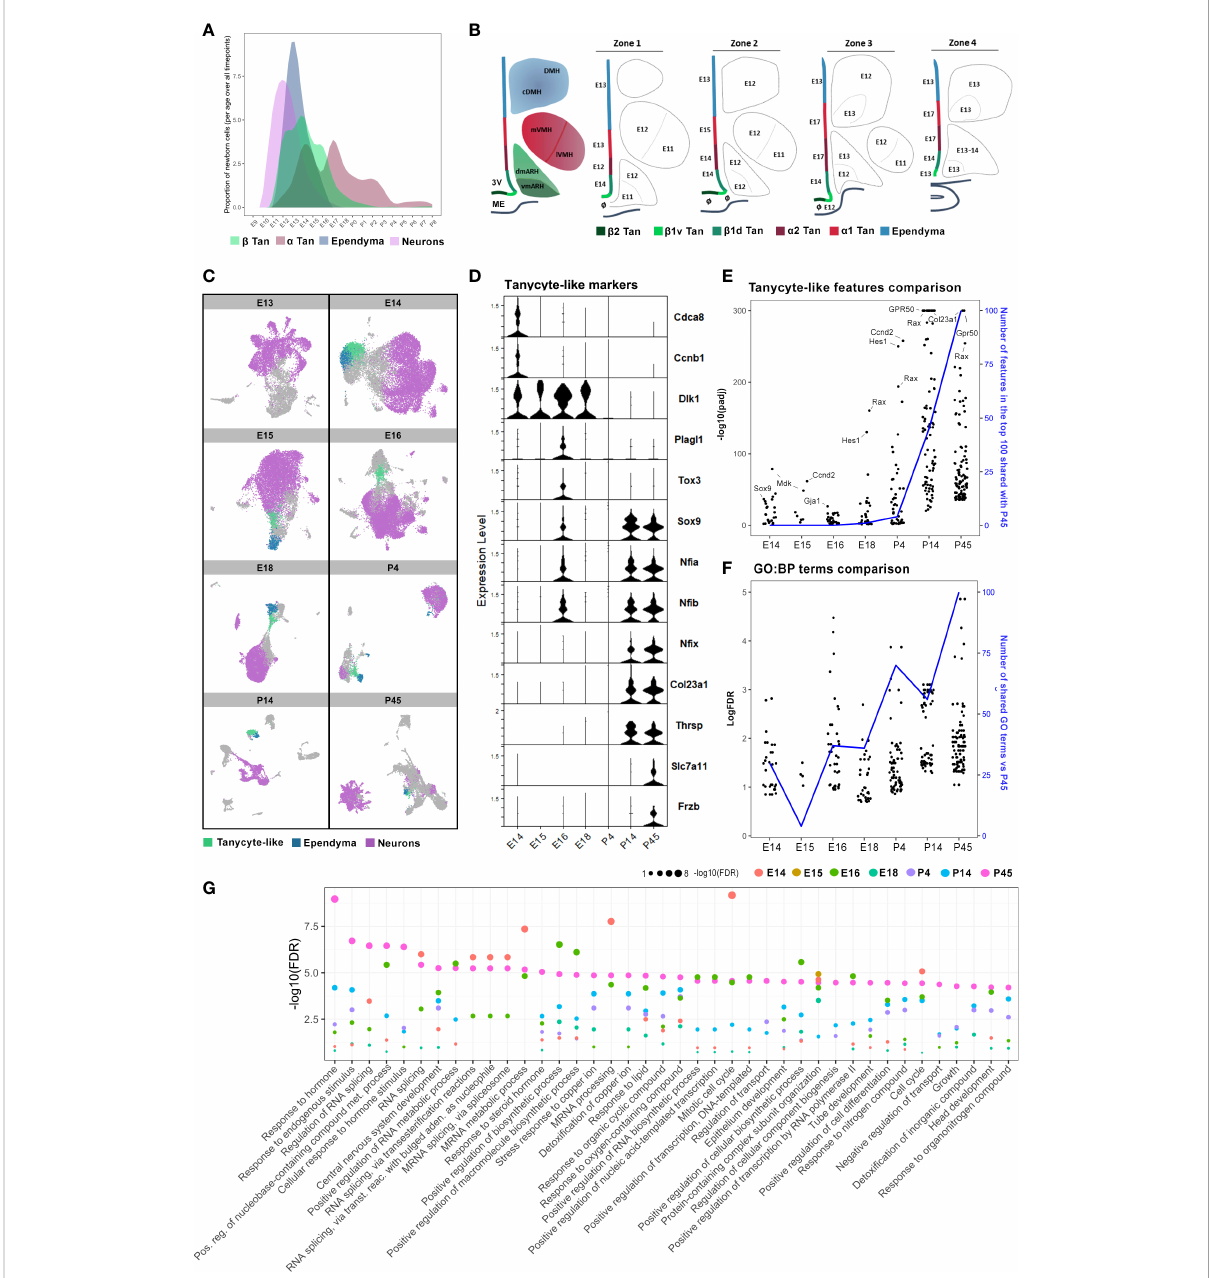
FIGURE 7 Cellular and molecular hypothalamic generation of mature tanycytes. (A) Representative plot illustrating the patterns of neuron, ependymal, and tanycyte generation across embryonic and early postnatal development extrapolated from our quanti fi cations. (B) Rostrocaudal neuroanatomical representations of the developmental peaks of BrdU integration along the ventricular wall and hypothalamic nuclei. The ages indicate the peaks of genesis. The symbol ø indicates no clear peak of genesis ( i.e ., either multiple peaks or a continuous generation). (C) UMAP plots showing neuron (pink), ependymal (blue), and tanycyte-like (green) clusters in diencephalic and hypothalamic scRNAseq datasets (26), from E13 to P45, per developmental time point. (D) Violin plot showing speci fi c features in tanycyte-like clusters across developmental time points from E14 to P45. (E) Comparison between the expression of the top 100 features of tanycyte-like cells at P45 versus those of tanycyte- like cells from every other developmental time point. The black dots represent features regarding their -log10(pAdj) signi fi cance. The blue line displays the number of features in the top 100 at each timepoint shared with the top 100 at P45. (F) Plot showing the comparison between the 100 more enriched GO terms from tanycyte-like cells at P45 (based on FDR) versus GO terms found in tanycyte-like cells from every other developmental time point. The black dots represent GO terms regarding their -log(FDR) signi fi cance. The blue line represents the number of GO terms shared in tanycyte-like clusters compared to P45. (G) Plot showing the -log10(FDR) of the top 40 more enriched GO terms in tanycyte-like cells at P45 compared to all time points. See Figure